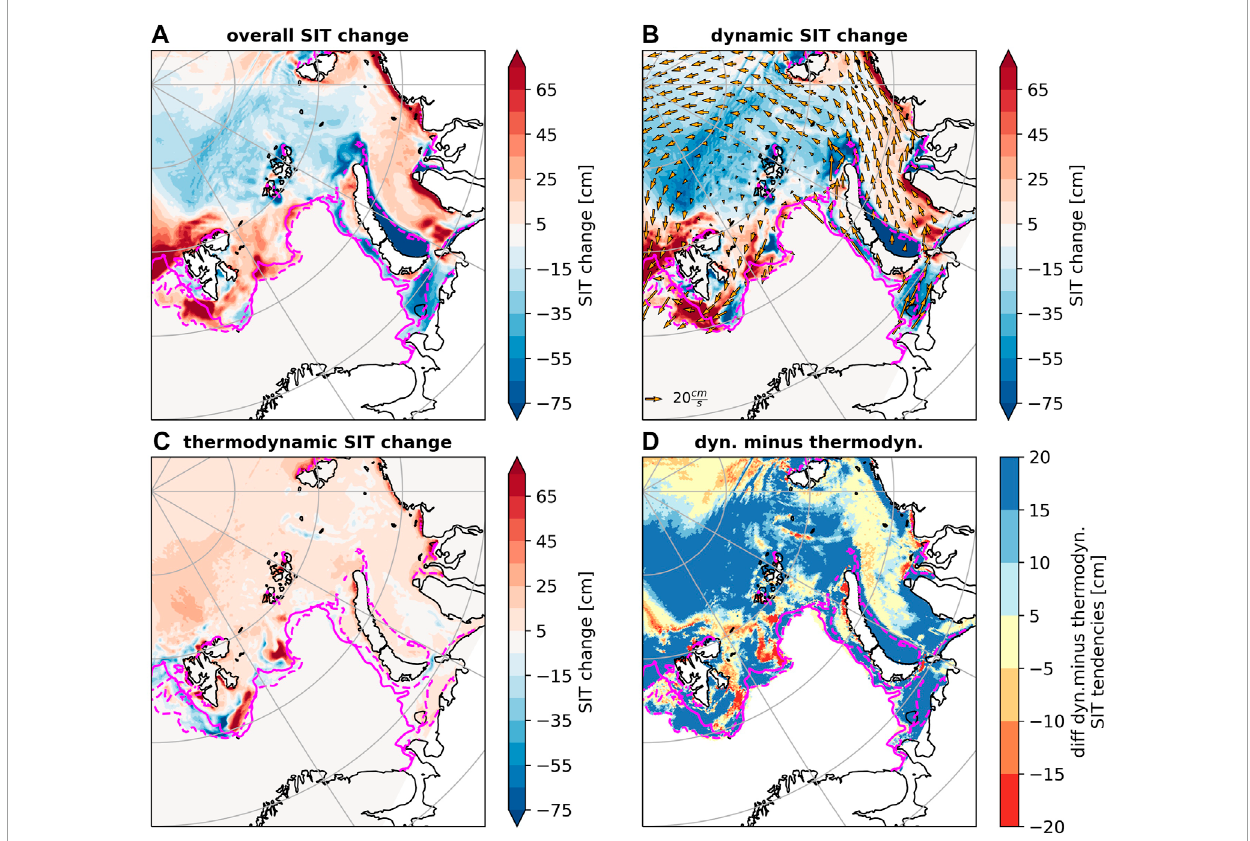
FIGURE 7 Overall SIT change during the whole sequence of cyclones (9.2.20-25.2.2020) (A) , temporally integrated dynamic SIT change as well as mean sea ice drift vectors (B) , temporally integrated thermodynamic SIT change (C) , and difference between absolute values of temporally integrated dynamic and thermodynamic SIT change (D) based on the HIRHAM–NAOSIM simulation. Solid (dashed) pink lines indicate the position of the ice edge (15% SIC) on 9.2.2020